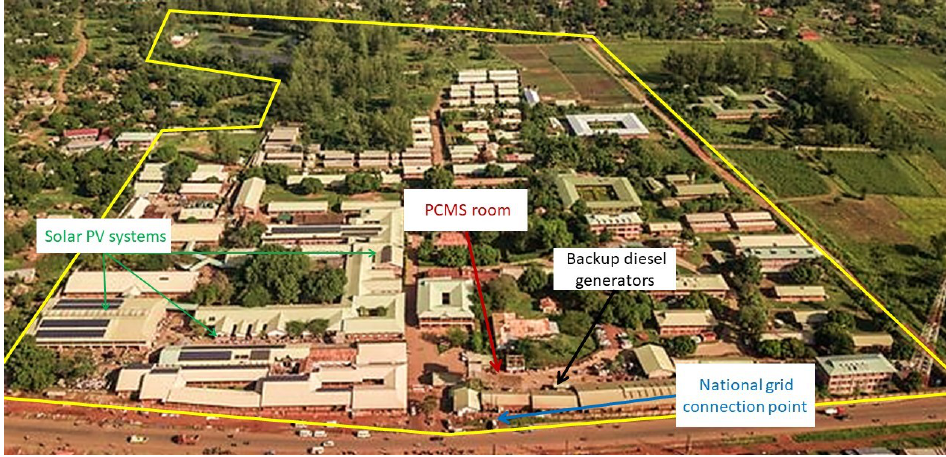
Figure 1. Overview of the hospital